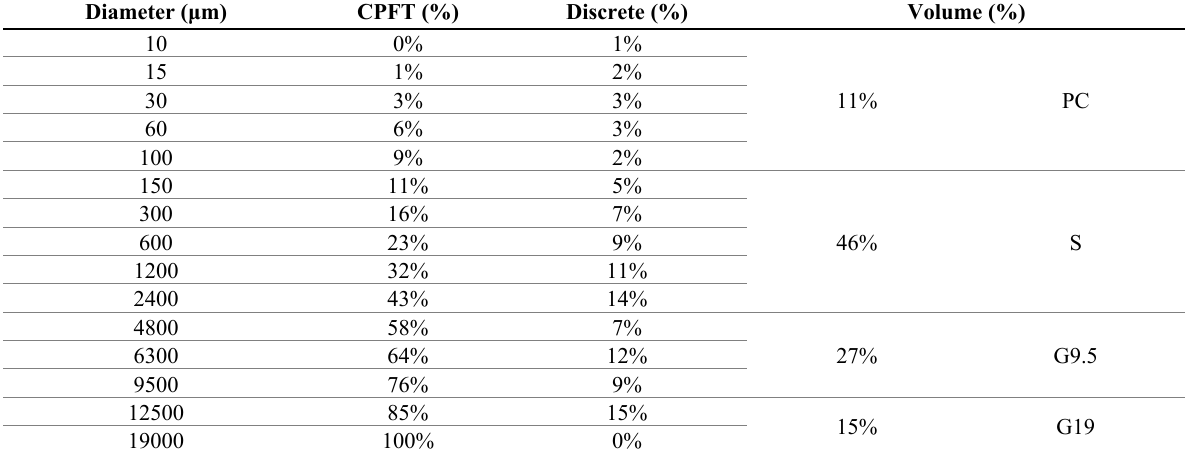
Table 3. Application of the Alfred model with q =